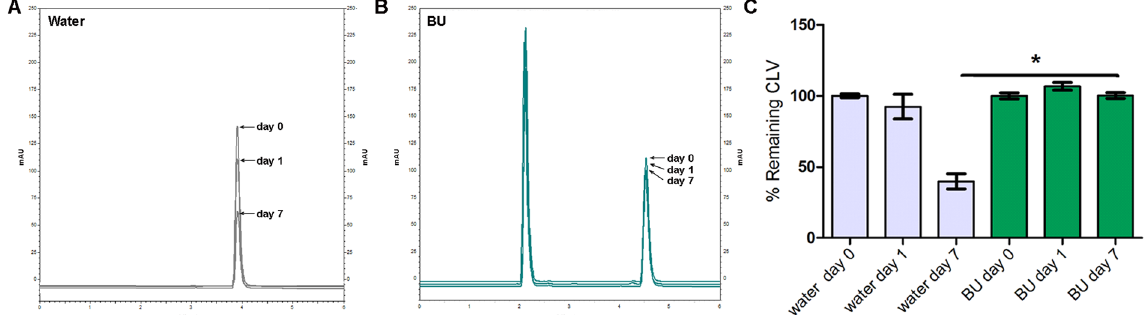
Figure 4. Representative chromatograms obtained of clavulanic acid (CLV) dissolved in water ( A ) and in BU ( B ) of samples of 1 mg/ml after 0, 1 and 7 days. ( C ) Shows chromatogram quantification. Results are expressed as median ± SEM of three experimental replicates.